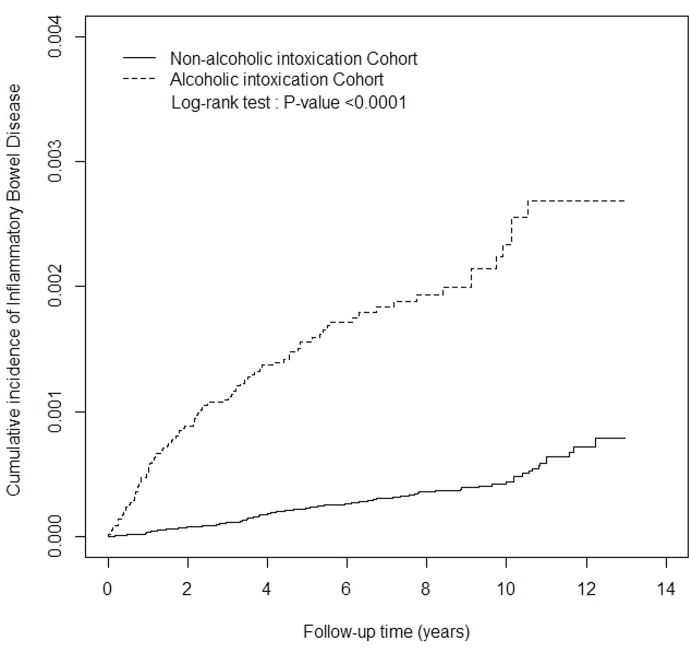
Cumulative incidence of inflammatory bowel disease.Cumulative incidence of inflammatory bowel disease in the alcoholic intoxication (dashed line) and nonalcoholic intoxication cohorts (solid line).